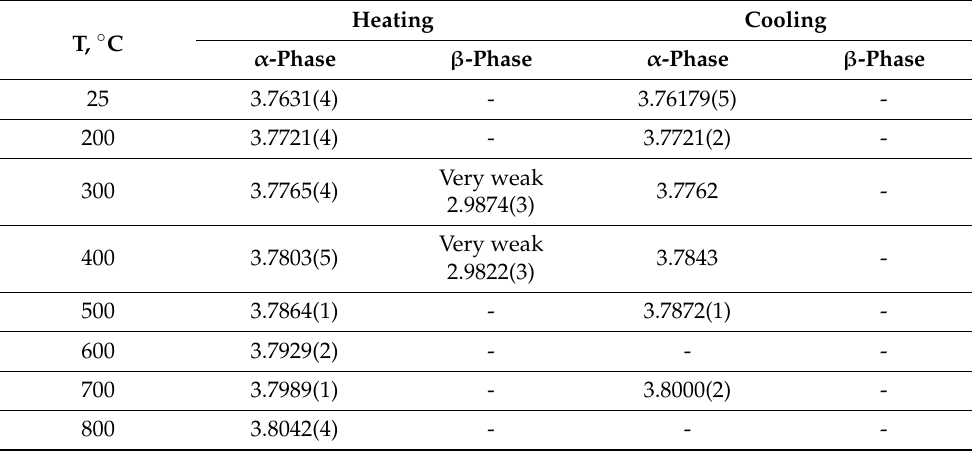
Figure 5. Change in the X-ray diffraction patterns of the Cu-Pd50 sample during ( a ) heating up to 25 (1), 200 (2), 300 (3), 400 (4), 500 (5), 600 (6), 700 (7), and 800 ° С (1 ′ ); ( b ) cooling down to 700 (2 ′ ), 500 (3 ′ ), 400 (4 ′ ), 300 (5 ′ ), 200 (6 ′ ), and 25 ° С (7 ′ ). Table 2 characterizes the phase composition on heating to 800 ° С and cooling down to room temperature. It follows from diffraction patterns 1, 3 and 4 that the initial structure is composed of a single phase ( α -phase), and at 300 and 400 ° С , very weak reflections of the β -phase appear. Table 2. Variation of the phase composition and crystal lattice parameters (a,Å) of the phases in the heating–cooling cycle of the Cu-Pd50 sample.